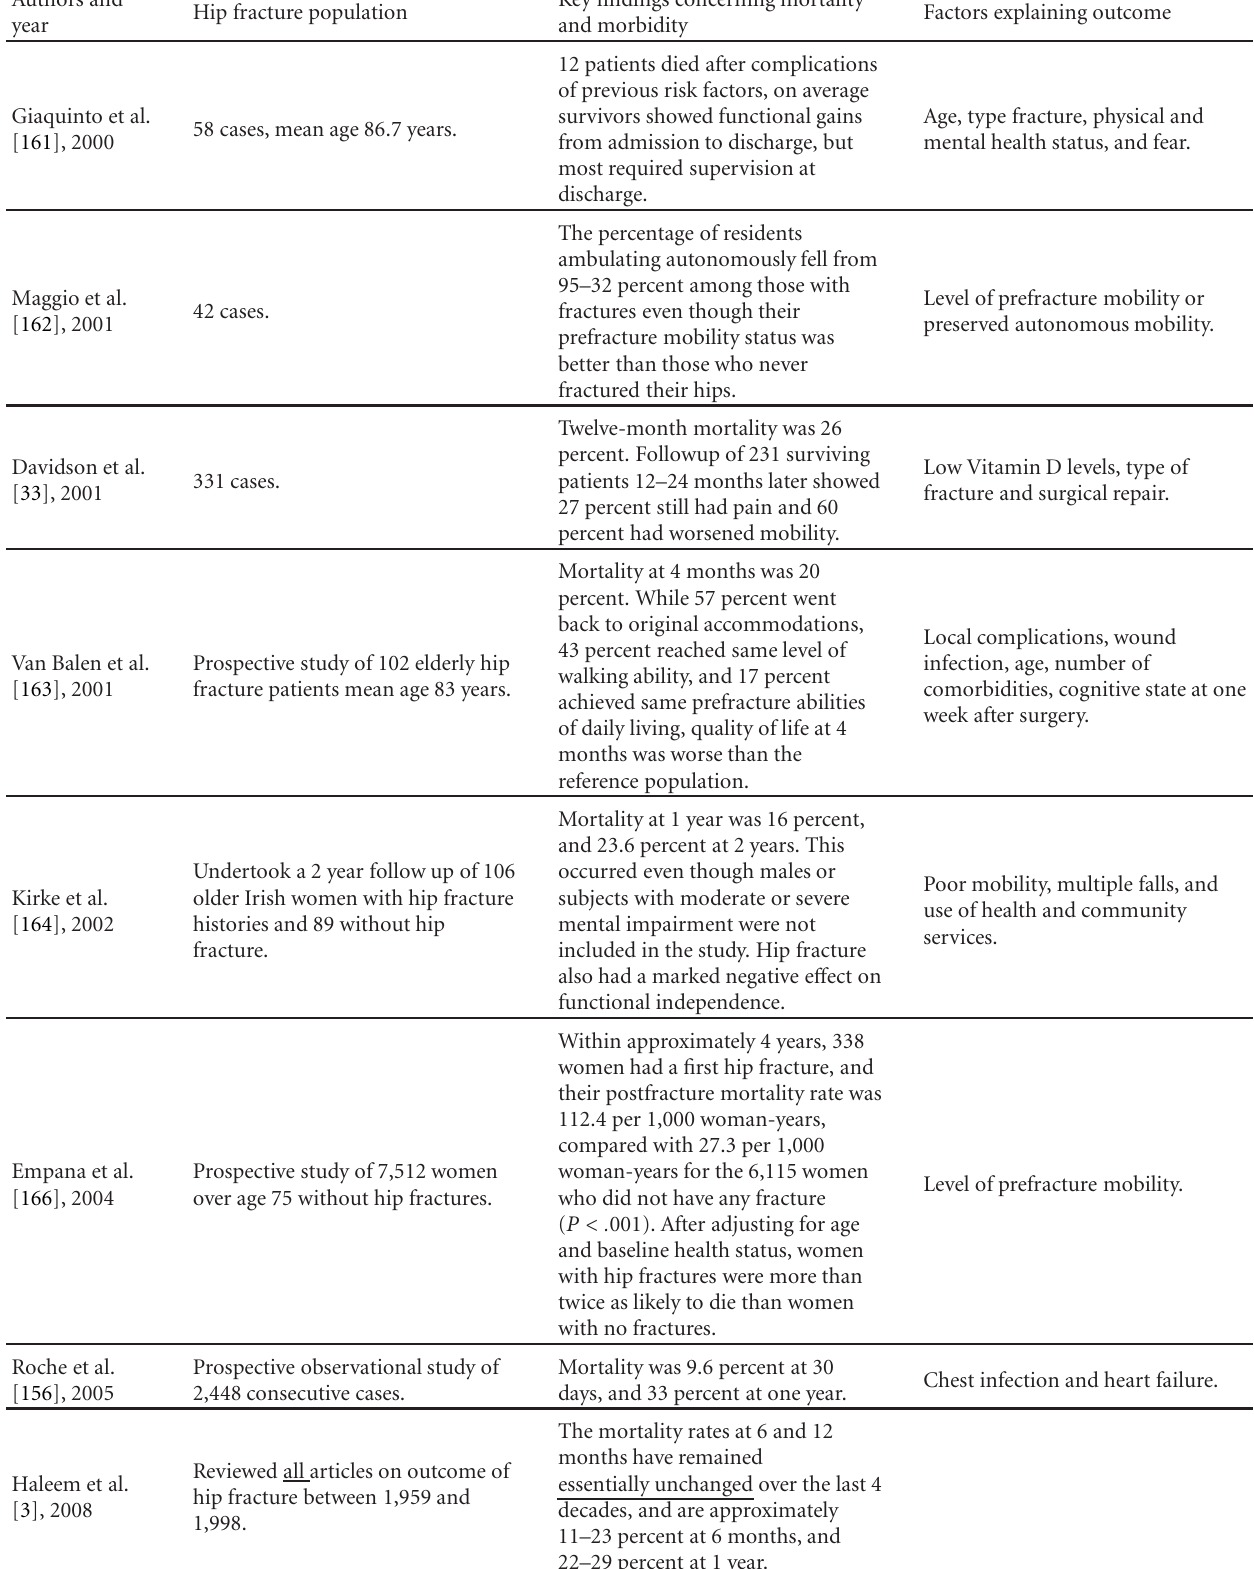
Table 4: Studies over last 10 years describing poor outcomes after hip fracture, regardless of contemporary management and rehabilitation strategies, plus some common factors explaining